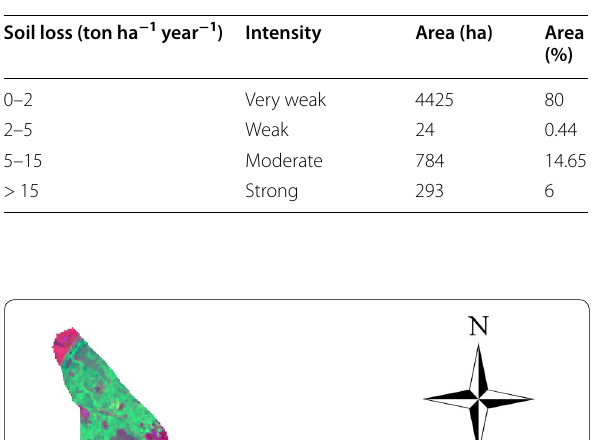
Table 2 Classification of soil loss rate in the Ikkour water-